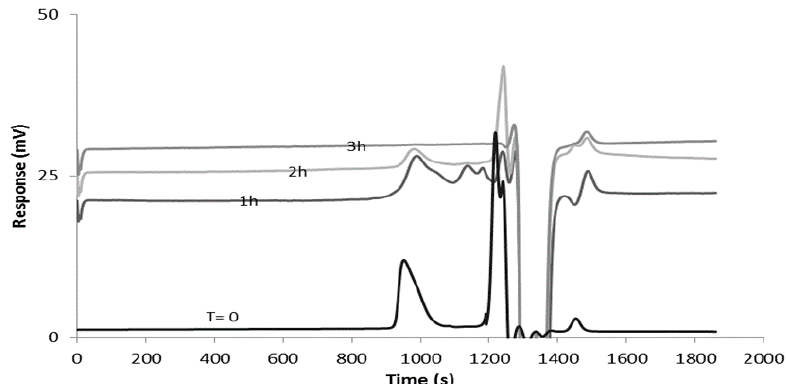
Figure 7. Overlaps of SEC traces recorded at various reaction time using the refractive index detector during the reductive degradation of the branched copolymer (PEGMEMA–PPGMA–DSDA/R:I, (20:70:10/1:0.2), entry 4, Table 1) with 0.1 M solution of DTT in THF at 20 °C.